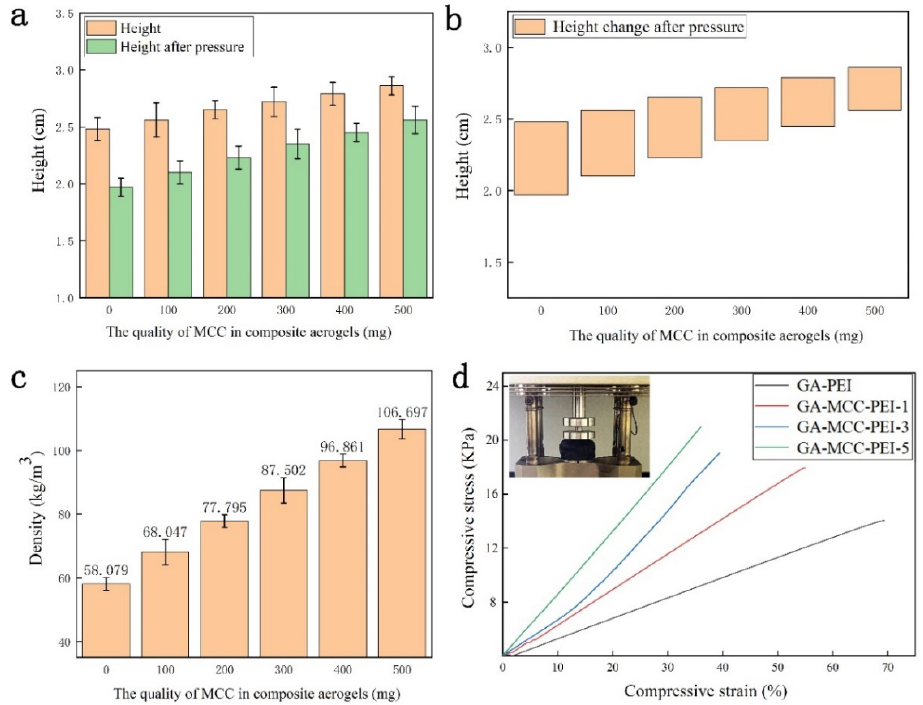
Figure 7. ( a ) Height maps of the GA-PEI and GA-MCC-PEI-(1–5) aerogels, ( b ) height change map after pressure, ( c ) density numerical map, and ( d ) stress—strain curve.